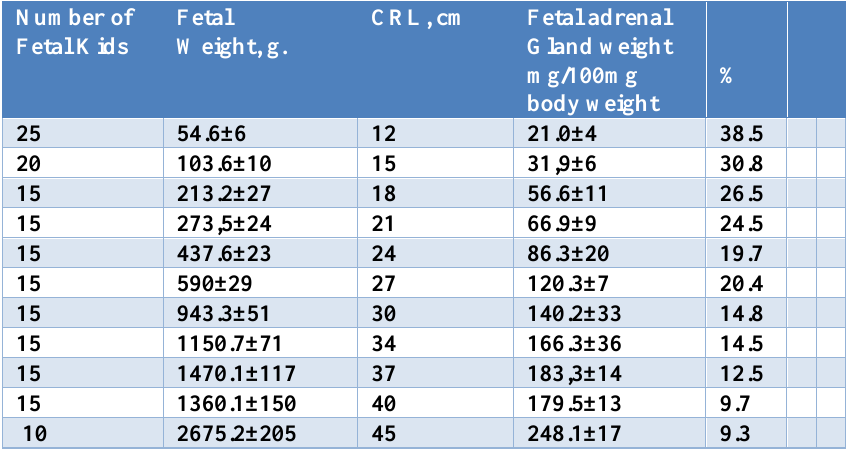
Table, 1: Fetal Crown Rump Length and weight. Absolute and relative weights of the Adrenal and pituitary gland in fetal Iraqi goat. Number of Fetal CRL, cm Fetal adrenal Fetal Kids Weight, g. Gland weight